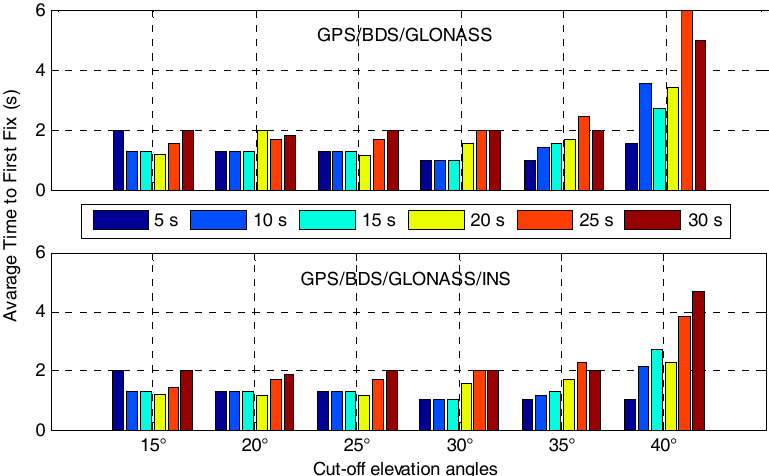
Figure 20. Average time to first fix the ambiguities after GNSS outage durations of 5, 10, 15, 20, 25 and